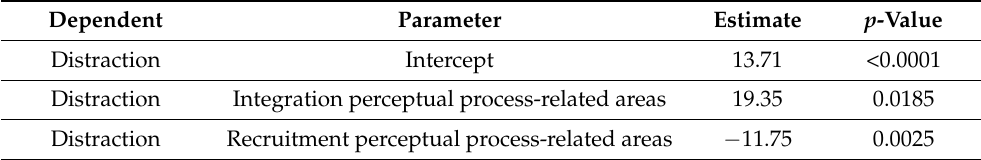
Table 5. Result of multivariate linear analysis, representing EEG features associated with the RAS surgeon distraction